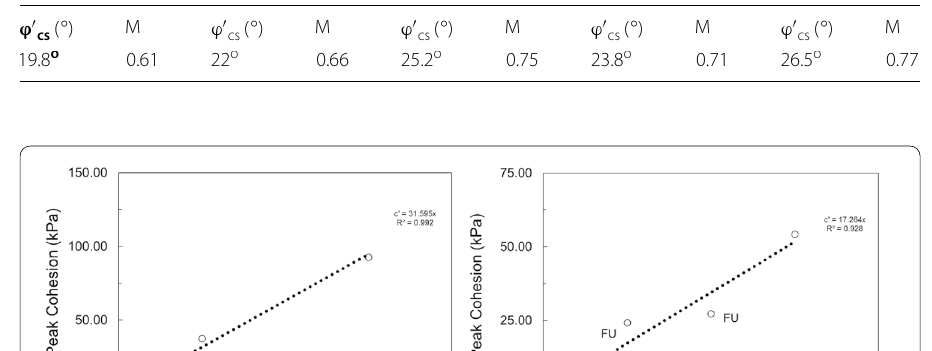
Fig. 10 Strength parameters for unreinforced, fibre, and fibre reinforced cemented Toyoura sand from CID tests a Peak cohesion versus fibre content b Peak cohesion versus cement content c Peak cohesion versus fibre with varying cement contents d Peak friction angle versus fibre content e Peak friction angle versus cement content f Peak friction angle versus fibre with varying cement